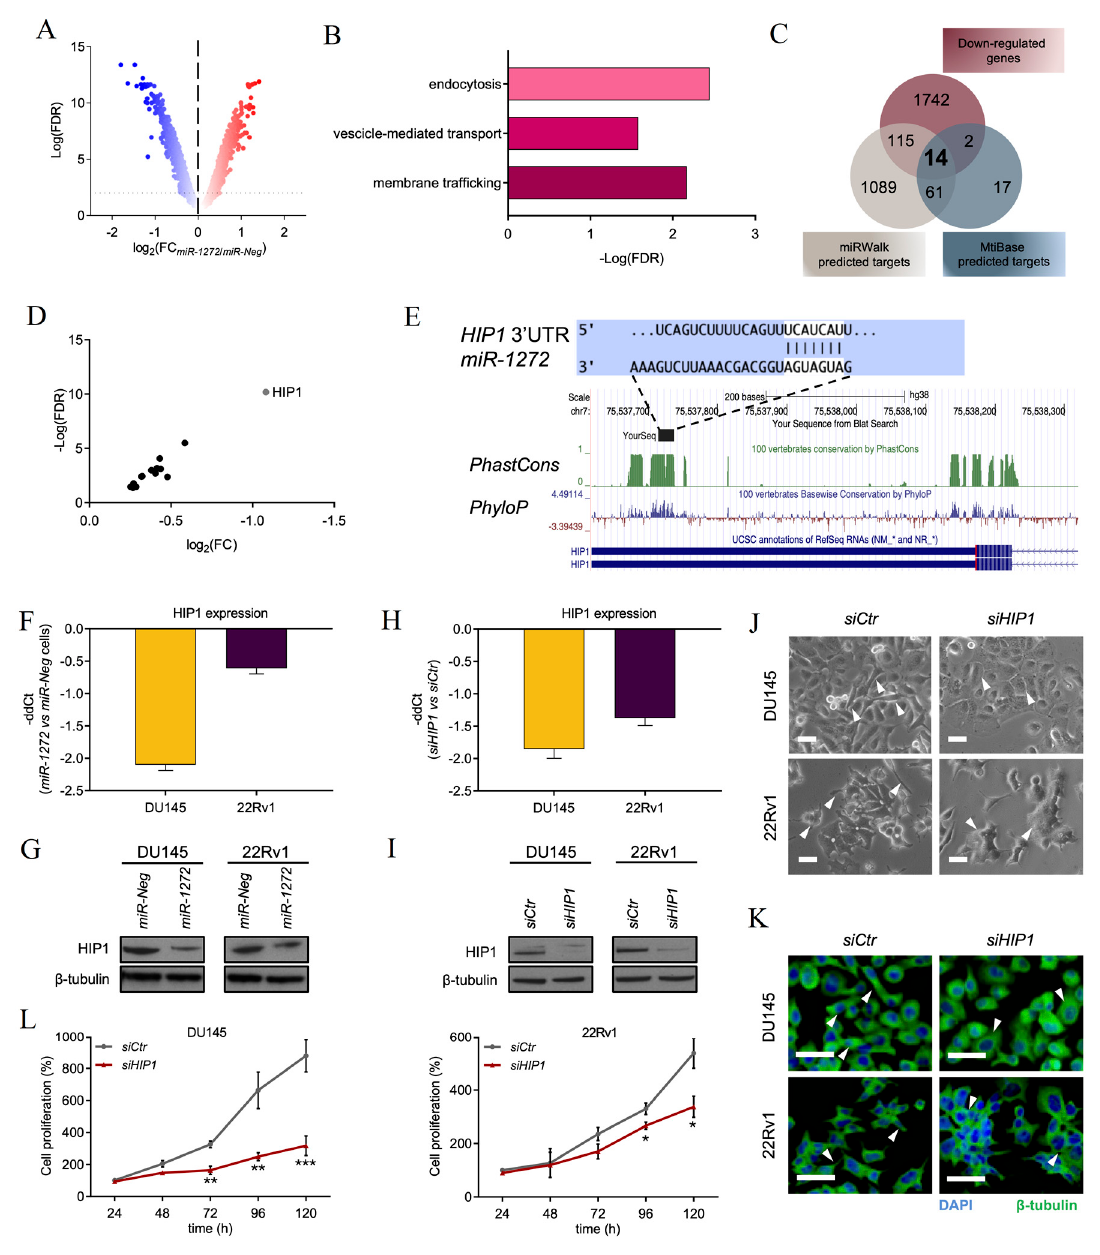
Figure 3. HIP1 is a functional target of miR-1272. ( A ) Volcano plot showing fold-change (FC) and false discovery rate (FDR) of di ff erentially expressed genes (red: up, blue: down) in miR-1272 transfected DU145 cells as compared to miR-Neg cells, as measured by microarray analysis. ( B ) Graph reporting FDR values of pathways enriched in gene ontology analysis carried out on genes di ff erentially expressed genes upon miR-1272 supplementation. ( C ) Venn diagram indicating the number of genes significantly down-regulated in microarray analysis of miR-1272 cells and the number of genes predicted to be targets of miR-1272 as from miRWalk or MtiBase. The fourteen genes shared among the 3 lists are included in Table 1. ( D ) Plot reporting FC and FDR values of the 14 genes emerging from intersections.( E ) Representation of miR-1272 duplexed with the 3 (cid:48) UTR of HIP1 mRNA, as from TargenScanHuman (http: // www.targetscan.org / vert_72 / ) (top). Conservation of the miRNA binding site across vertebrates is made evident by graphs of PhastCons and PhyloP scores, as from UCSC Genome Browser (https: // genome.ucsc.edu) (bottom). ( F ) RT-qPCR showing the relative expression of HIP1 in miR-1272 transfected DU145 and 22Rv1 cells with respect to miR-Neg cells, at day 2 after